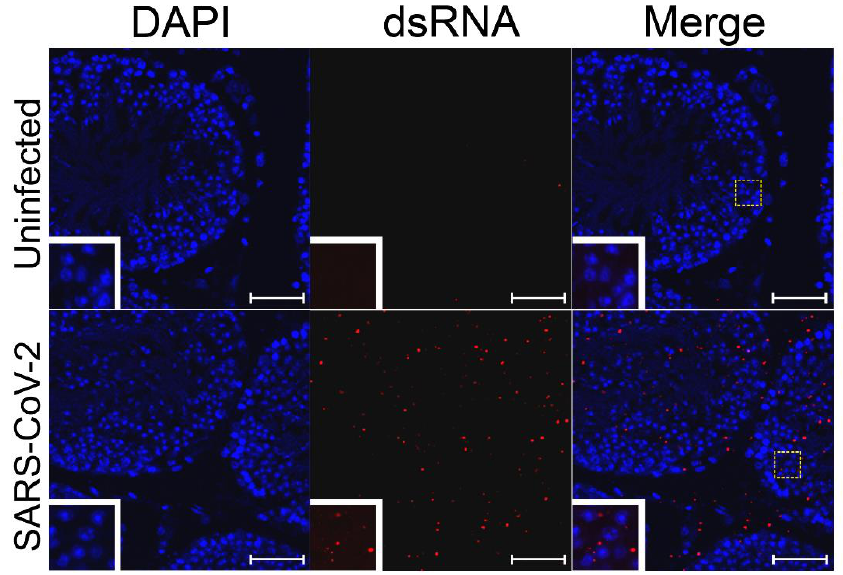
Figure 2. SARS-CoV-2 dsRNA in ex vivo-infected testes. Ex vivo testicular tissue was fixed and sectioned 24 hpi. Sections were stained for dsRNA (J2, red) and for cell nuclei (DAPI, blue). The white dashed boxes show the region of the figure from which the inset was magnified. White bars indicate a length of 5 µm.